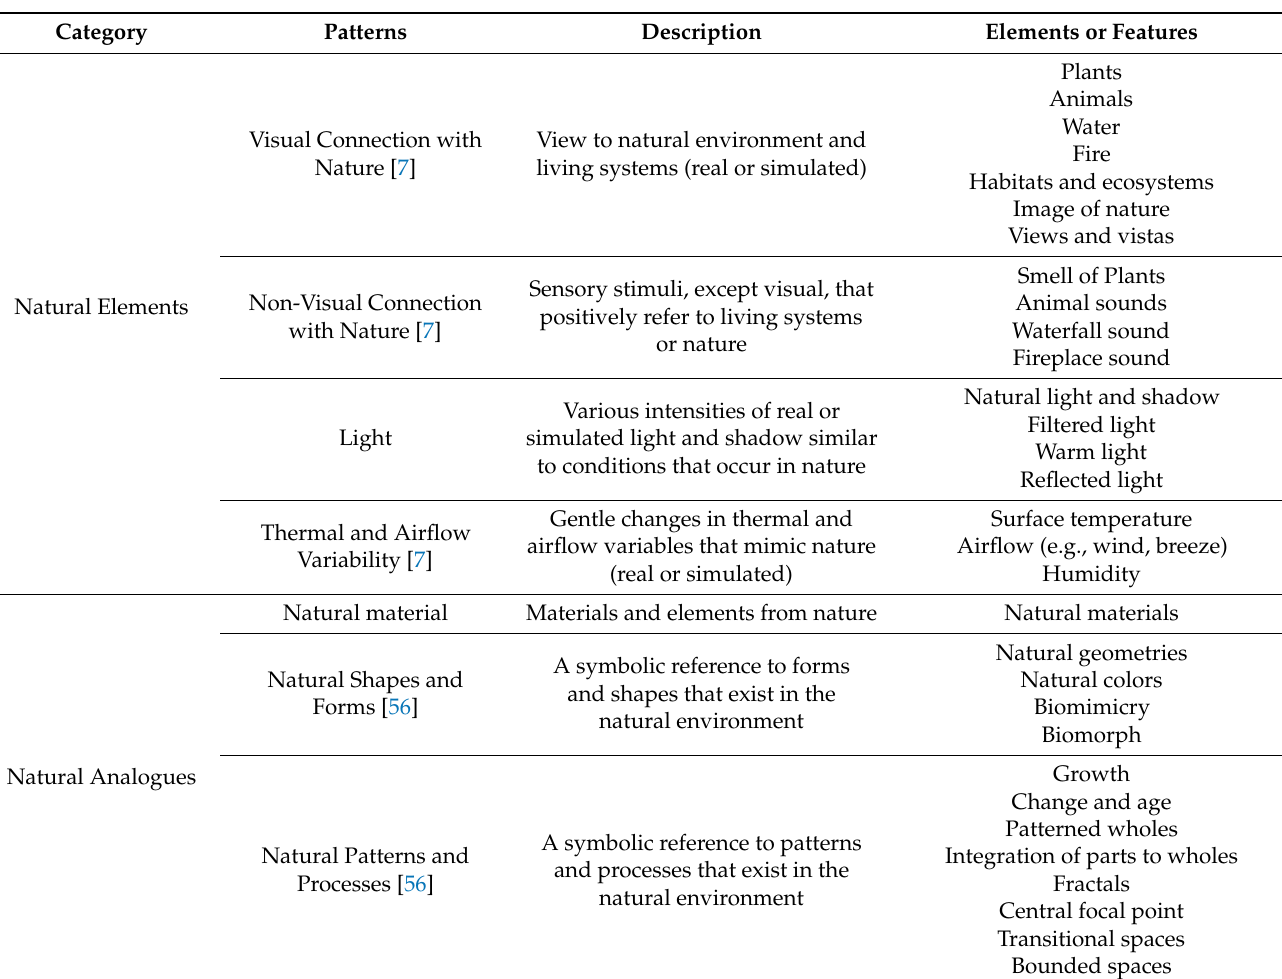
Table 1. Summary of biophilic categories, patterns, and elements or features based on [7,55–58]. Category